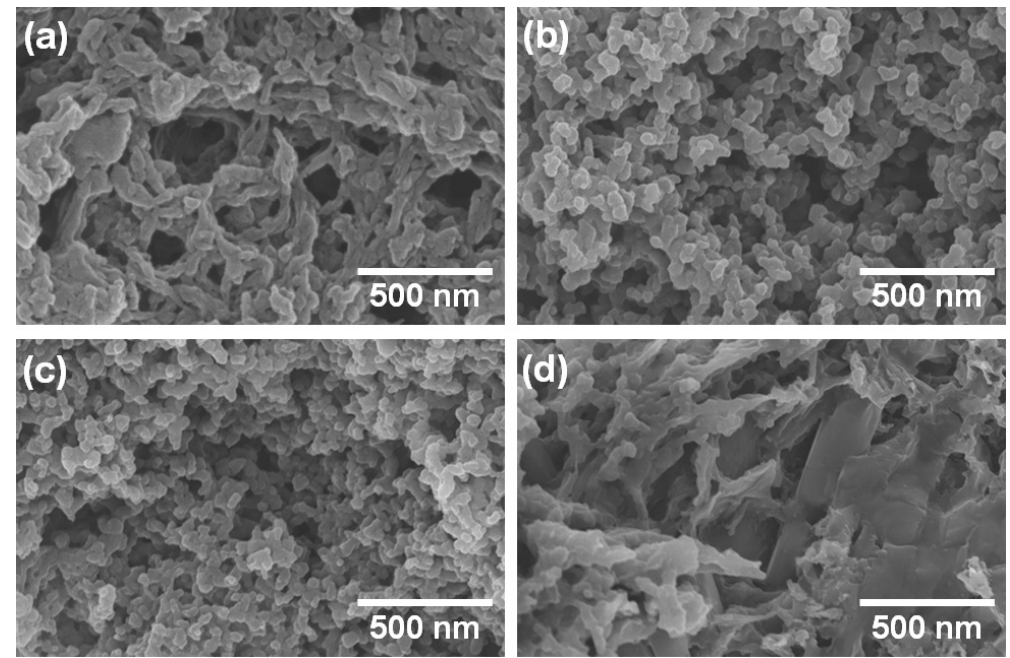
Figure 3. FE-SEM images of PVA–PANI HDGs with ( a ) 5 wt.% PVA, ( b ) 10 wt.% PVA, and ( c ) 15 wt.% PVA. ( d ) FE-SEM image of PVA–PANI–MLG HDG with 5 wt.% PVA and 3 wt.% MLG.